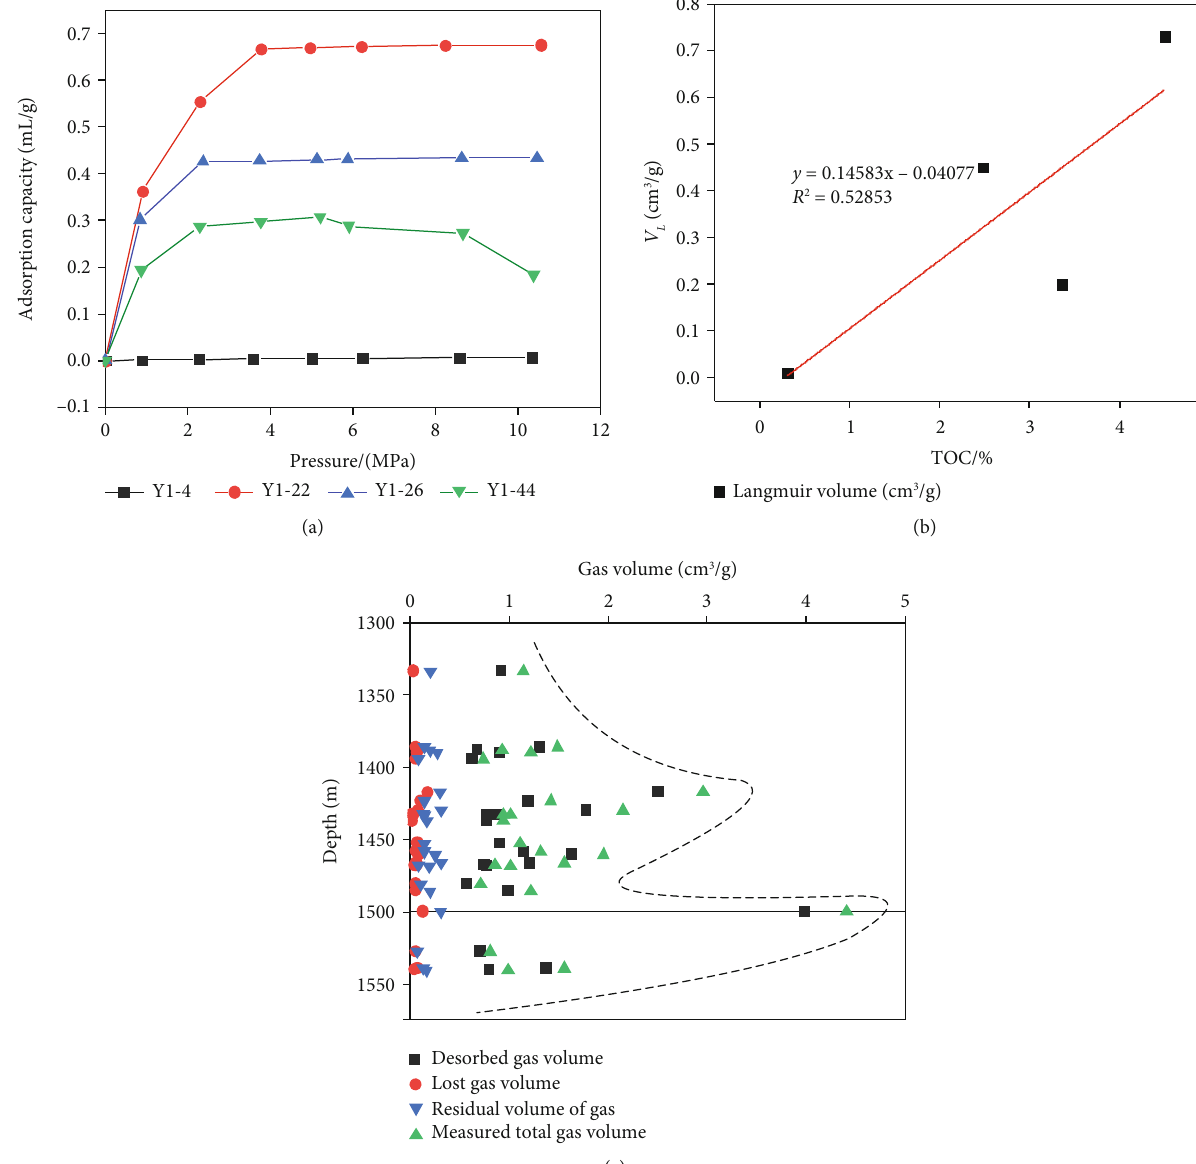
Figure 9: CH4 isothermal adsorption curve and vertical gas content change curve of well